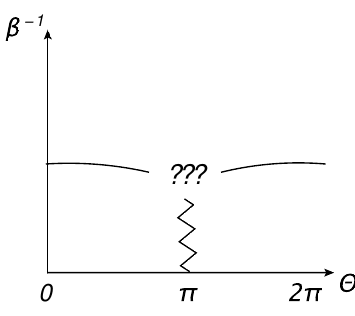
Figure 1 . Known information about the phase diagram of SU(2) gauge theory as a function of θ and temperature β − 1 . The smooth line is a second order transition in the Ising 3d universality class. The zigzag line is expected to be a first order transition. There are 2 vacua on the zigzag line and one vacuum on each side of it. Later in this paper we will discuss the region with question